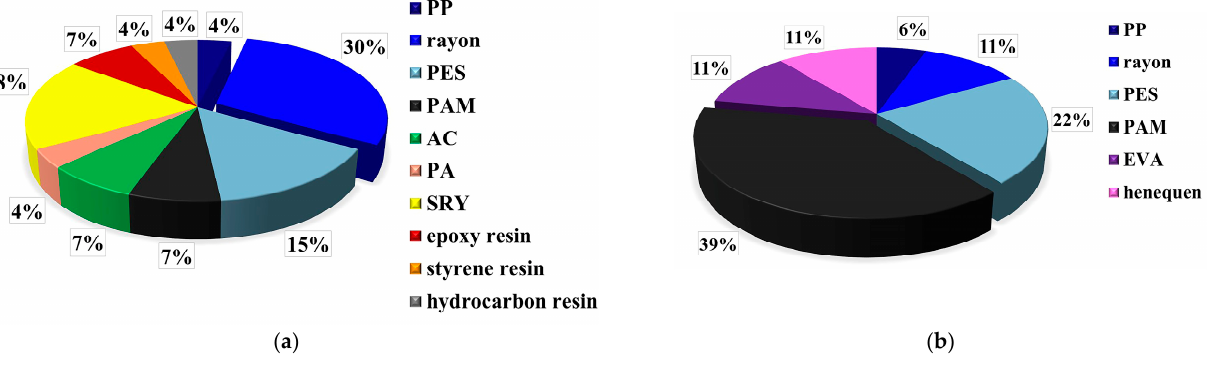
Figure 3. The percentages of different compositions of MPs in order Perciformes: ( a ) in the AS; ( b ) in the RS, Antarctica.